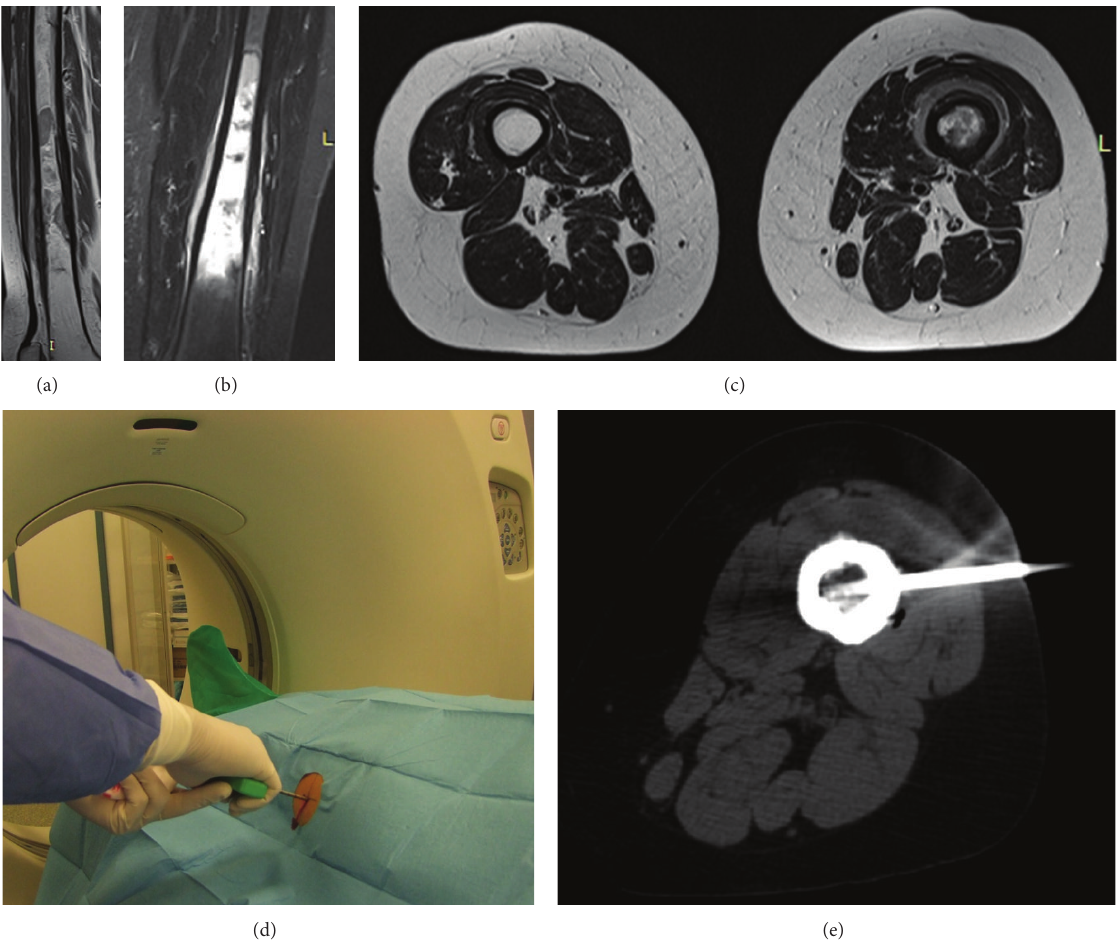
Figure 2: Sagittal MRI T1 (a), coronal MRI STIR (b), and axial MRI T2 (c) scans of the right thigh show heterogeneous intratumoral hypointensive signal on T1 and hyperintensive signal on T2 in the diaphysis of the femur. An 8-gauge core-needle bone biopsy inserted under CT guide (d) into marrow of the right femur (e). Diagnosis: